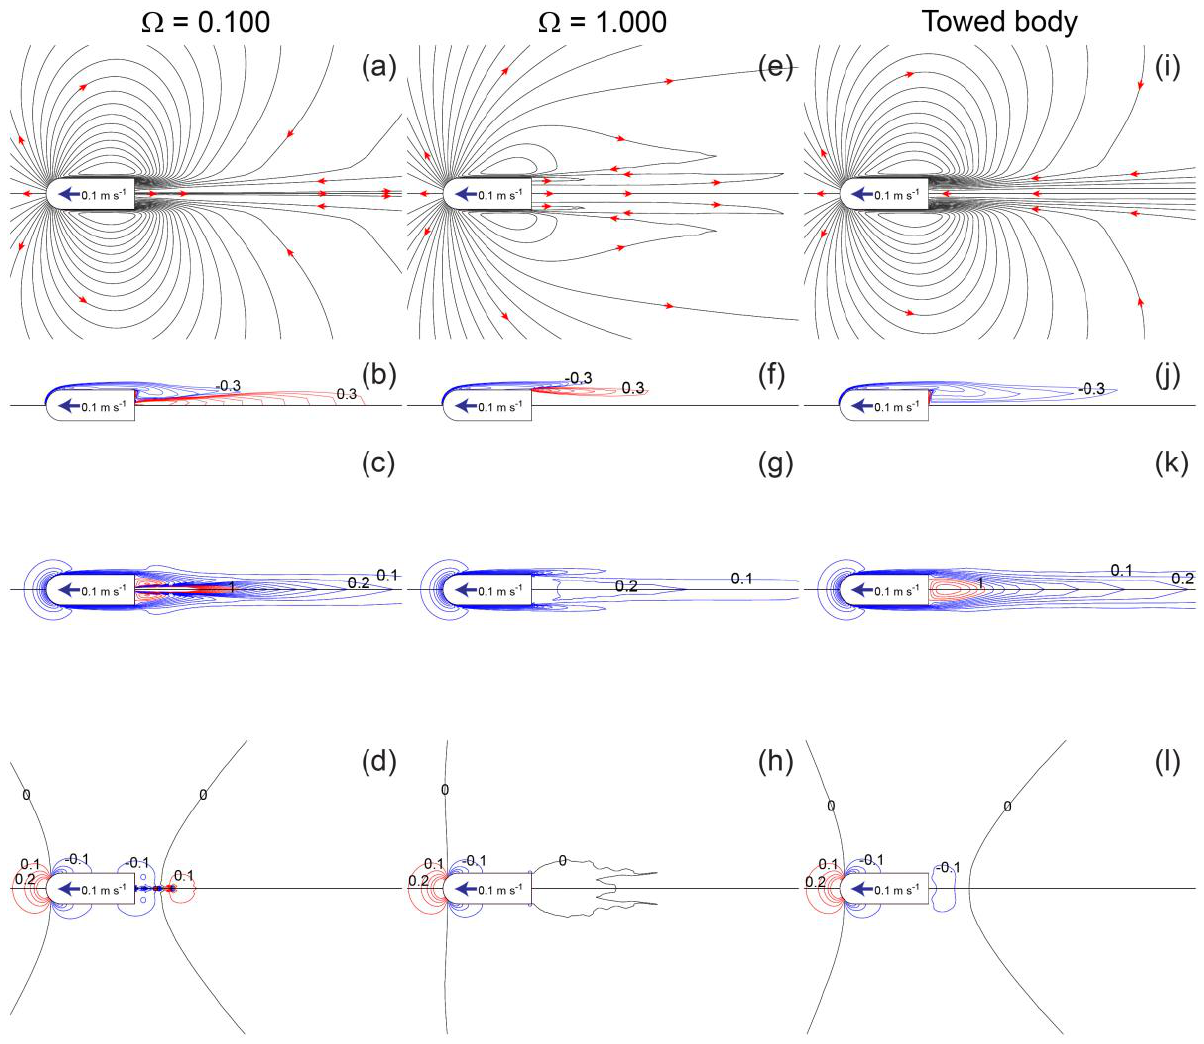
Figure 5. Re = 1886.0. CFD-simulated flow fields imposed, respectively, by the jet-propelled body R3-S ( a – d ) and R3-B ( e – h ) and by the towed body T3 ( i–l ), all of which move steadily at U = 0.1 m s −1 . Explanations of the panels are the same as in Figure 4.